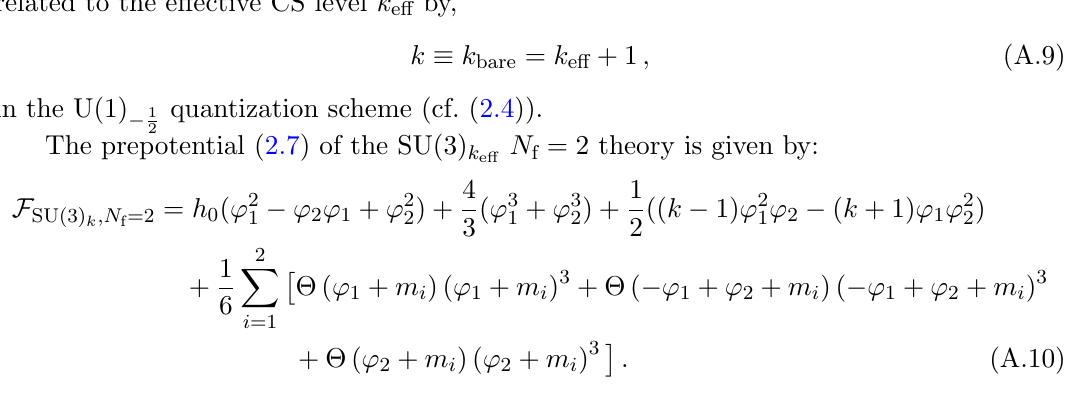
or SU(3) k gauge theory with N f = 2 (cid:13)avors. The eff eff The SU(3) k N f = 2 theory is likewise speci(cid:12)ed by e(cid:11) R . Table 2